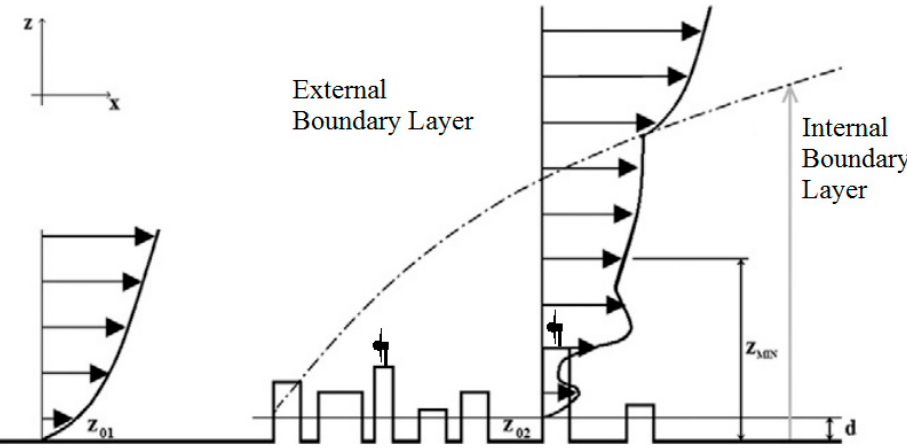
Figure 11. Wind velocity profile in the internal boundary layer in an urban area.